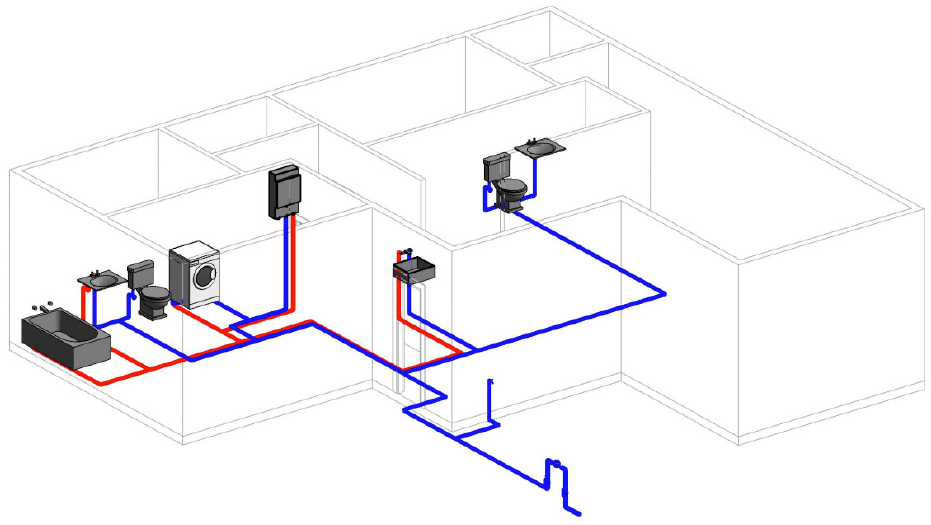
Figure 5. Sanitary plumbing network layout in a single-family house. Table 6. Global data for the single-family house case study.